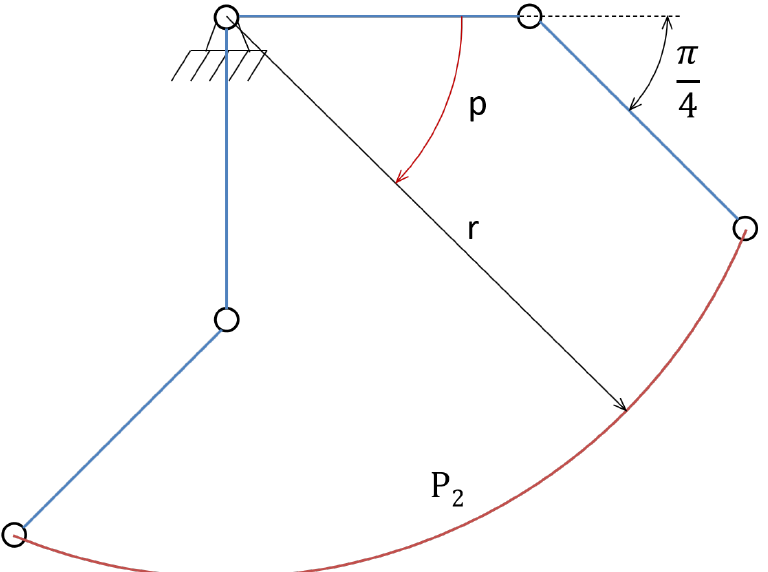
Figure 2. Flexible robot endpoint trajectory.